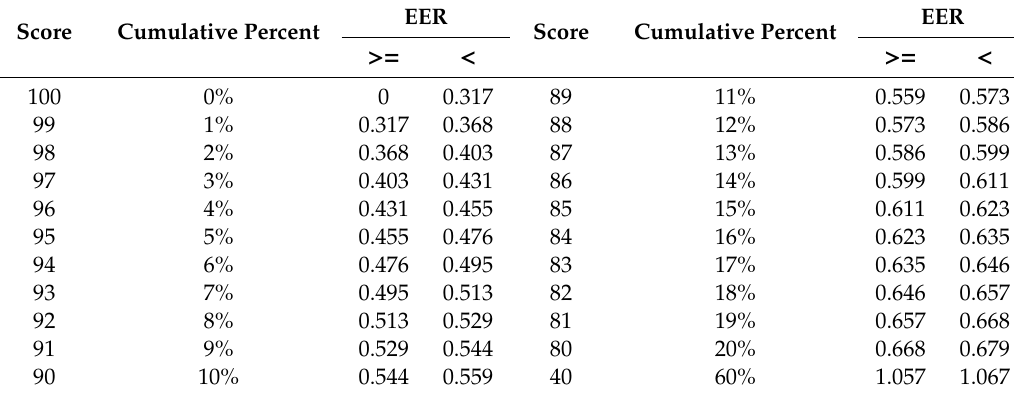
Table 9. Look-up table based on EER calculation